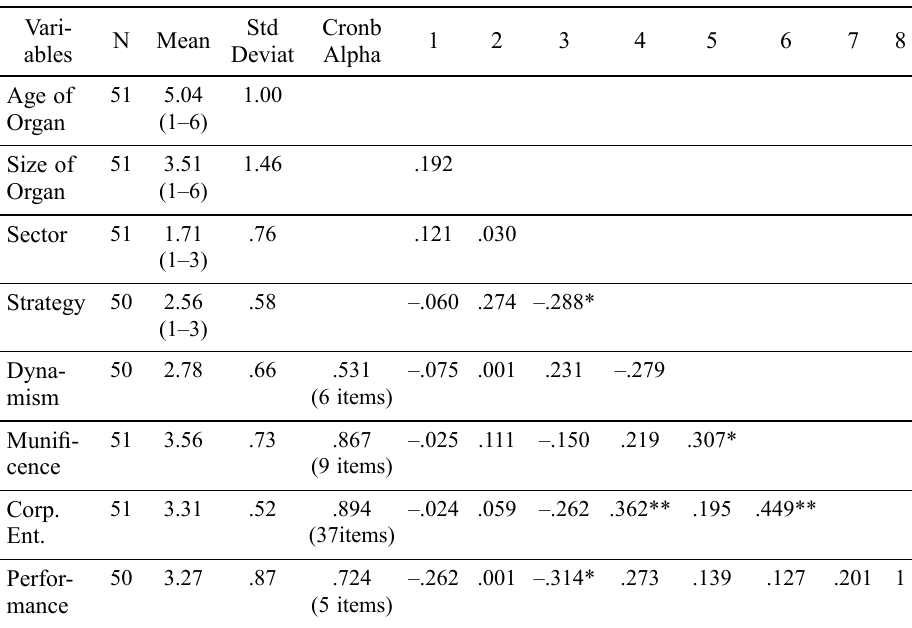
Table 2 . Summary descriptive statistics, reliabilities and correlation